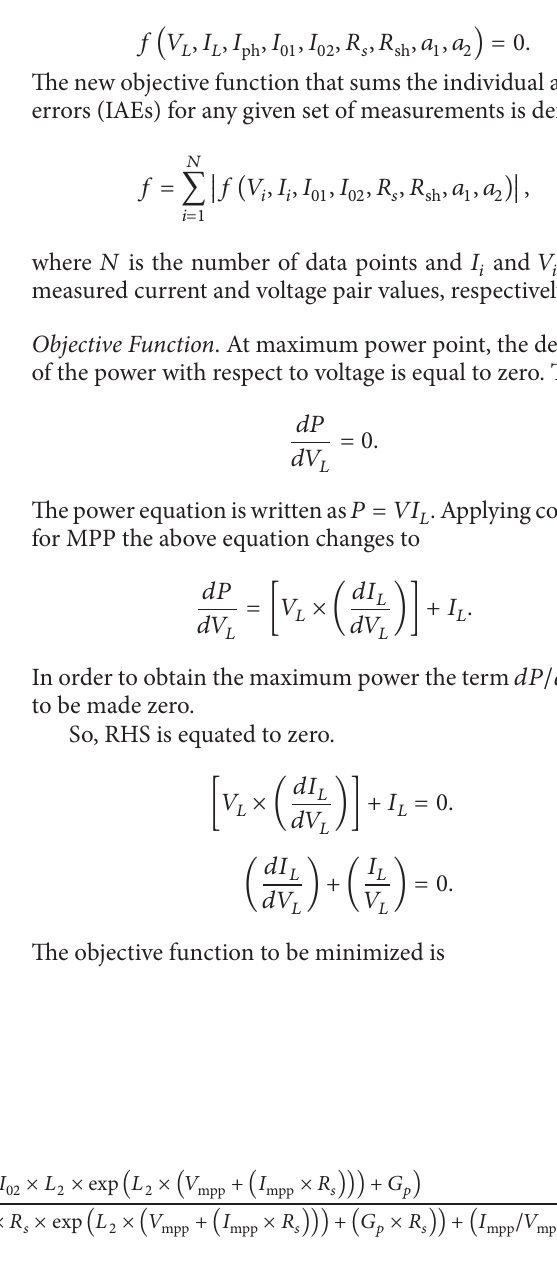
Figure 2: Double diode model of solar